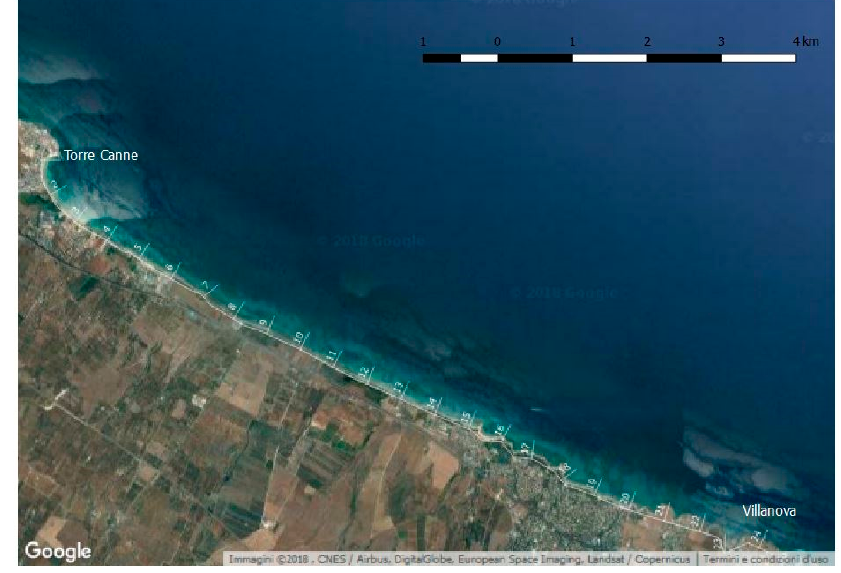
Figure 2. Case study area and related transects.